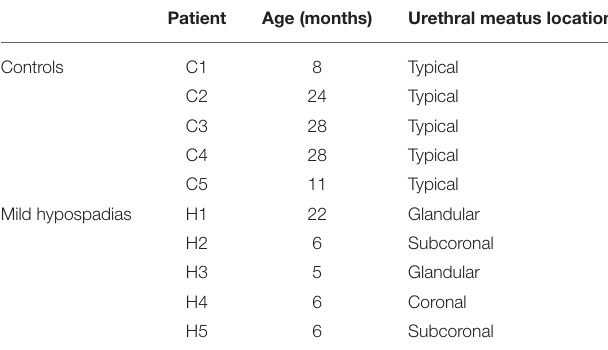
TABLE 1 | Clinical characteristics of patients at the time of